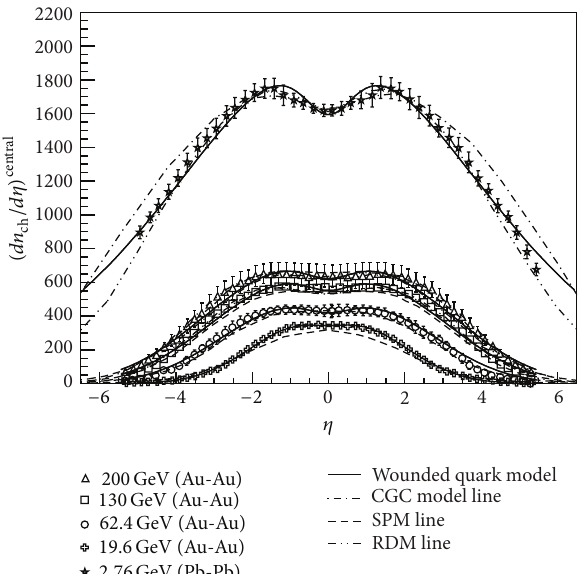
Figure 7: Charged hadron pseudorapidity distribution in Au-Au collisionsatdifferentRHICenergiesandPb-PbatLHCenergyalong with comparison of different model results. Data are taken from [119, 120, 126, 128].